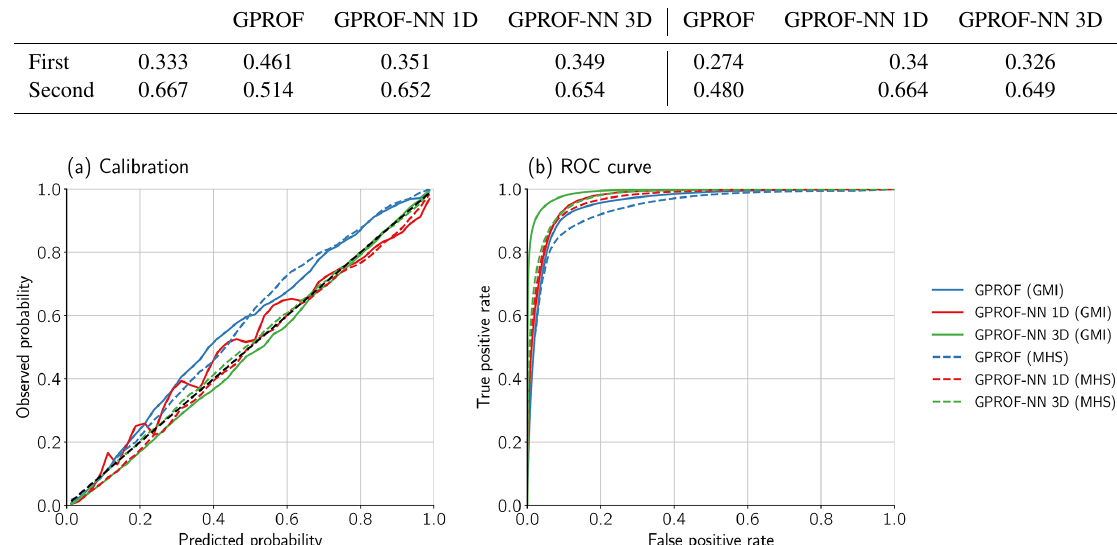
Figure 9. Calibration (a) and receiver operating characteristic (ROC, b ) for the predicted probability of